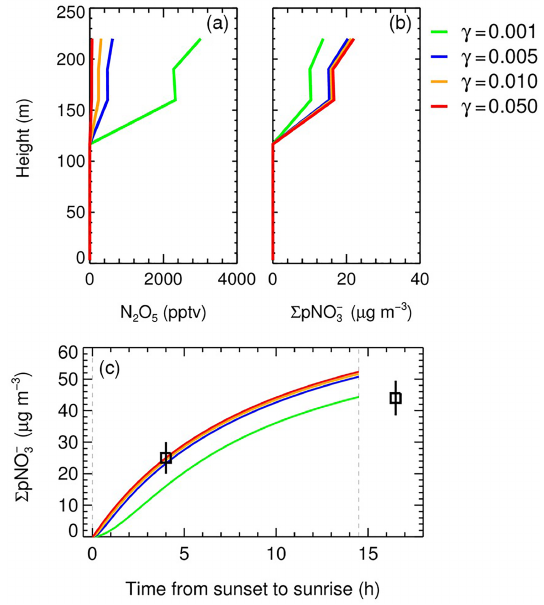
Figure 6. Base case ( γ = 0.005) and sensitivity tests of the vertical profile on the night of 19 December at different N 2 O 5 uptake coeffi- cients, including (a) the mixing ratio of N 2 O 5 at 21:00, (b) the inte- gral p NO − production from sunset to 21:00, and (c) the time series 3 of the integral p NO − formed at 240m via N 2 O 5 uptake from sun- 3 set (17:00) to sunrise (07:30; nighttime length 14.5h). The squares represent the p NO − equivalent weight from the observed O x miss- 3 ing in the two vertical measurements at ∼ 21:00 and ∼ 09:30 on the following